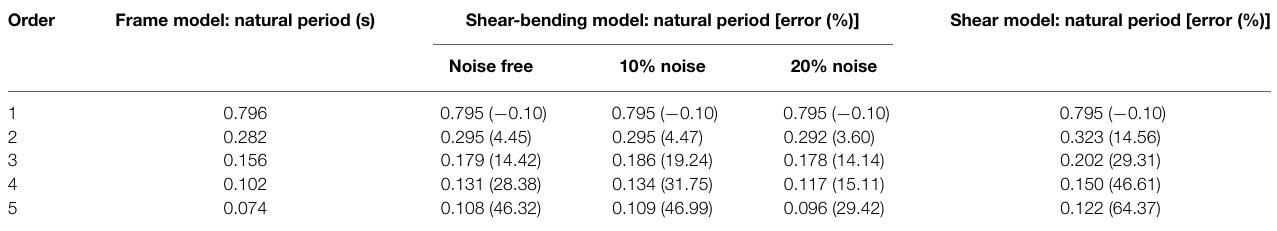
TABLE 4 | Comparison of natural